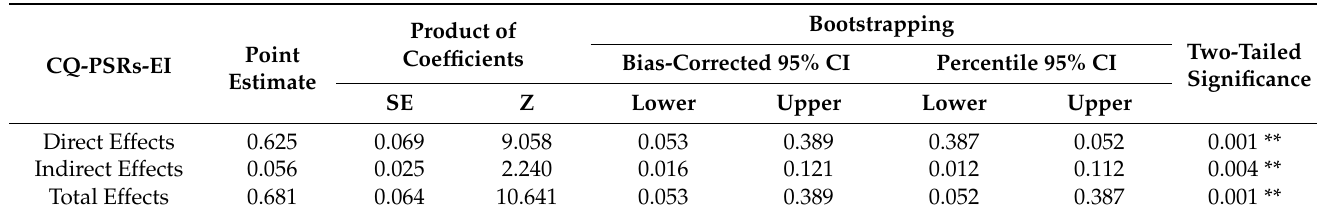
Table 6. Unstandardized direct, indirect, and total effects of the hypothesized model.